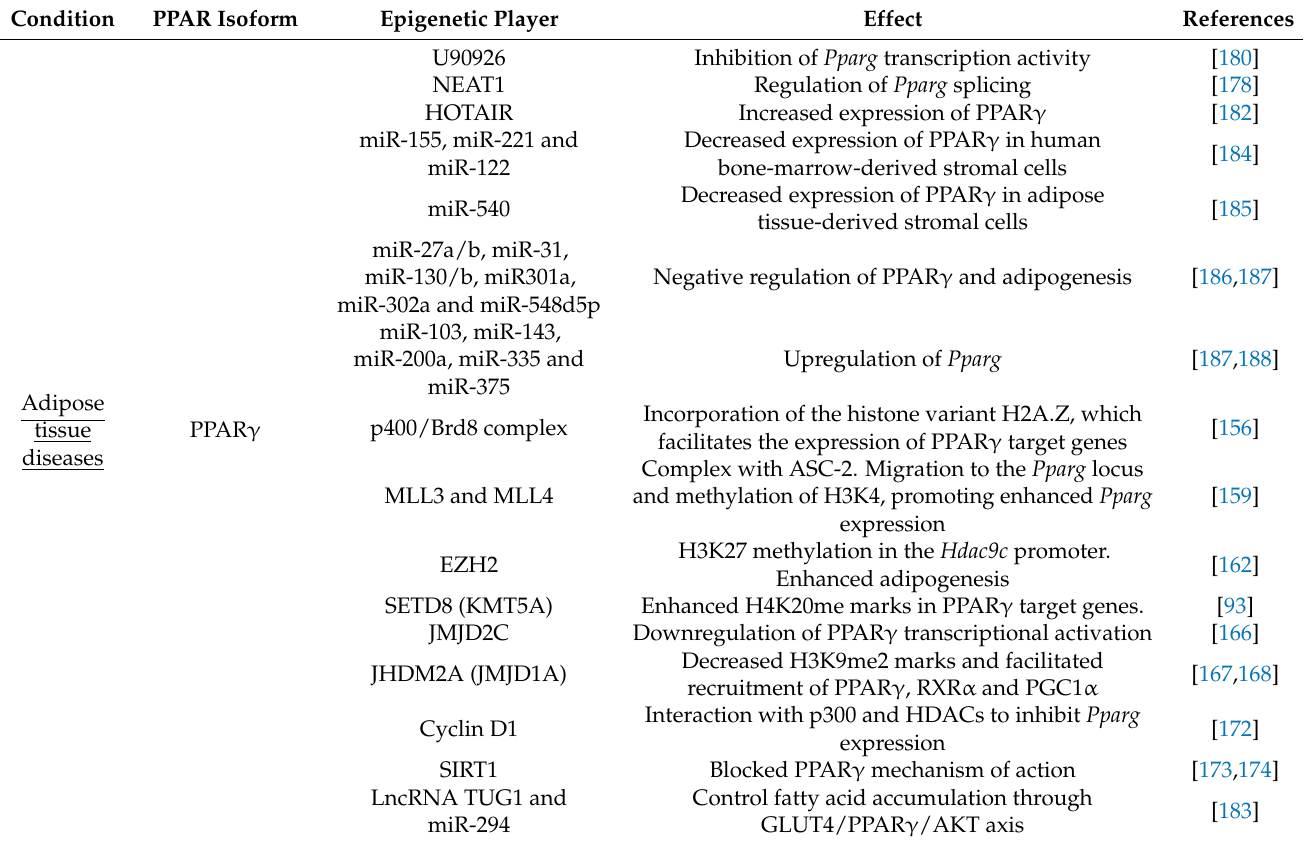
Table 5. PPAR γ epigenetics in adipose tissue